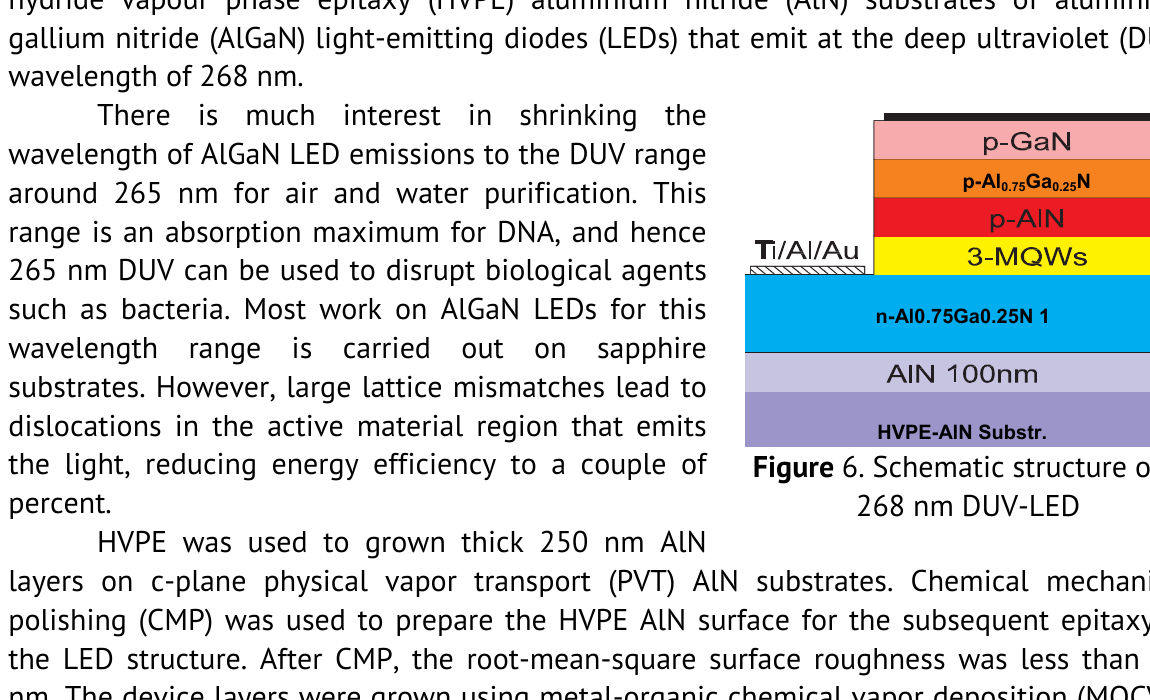
p-Al 0.75 Ga 0.25